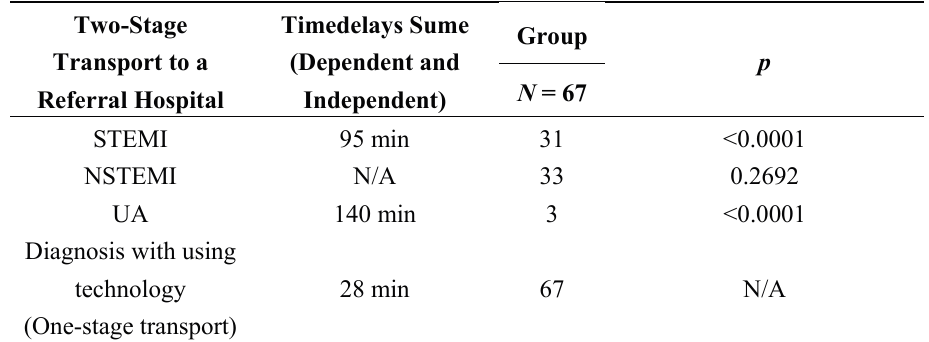
Table 2. Comparison of time delay between one and two-stages of hospital